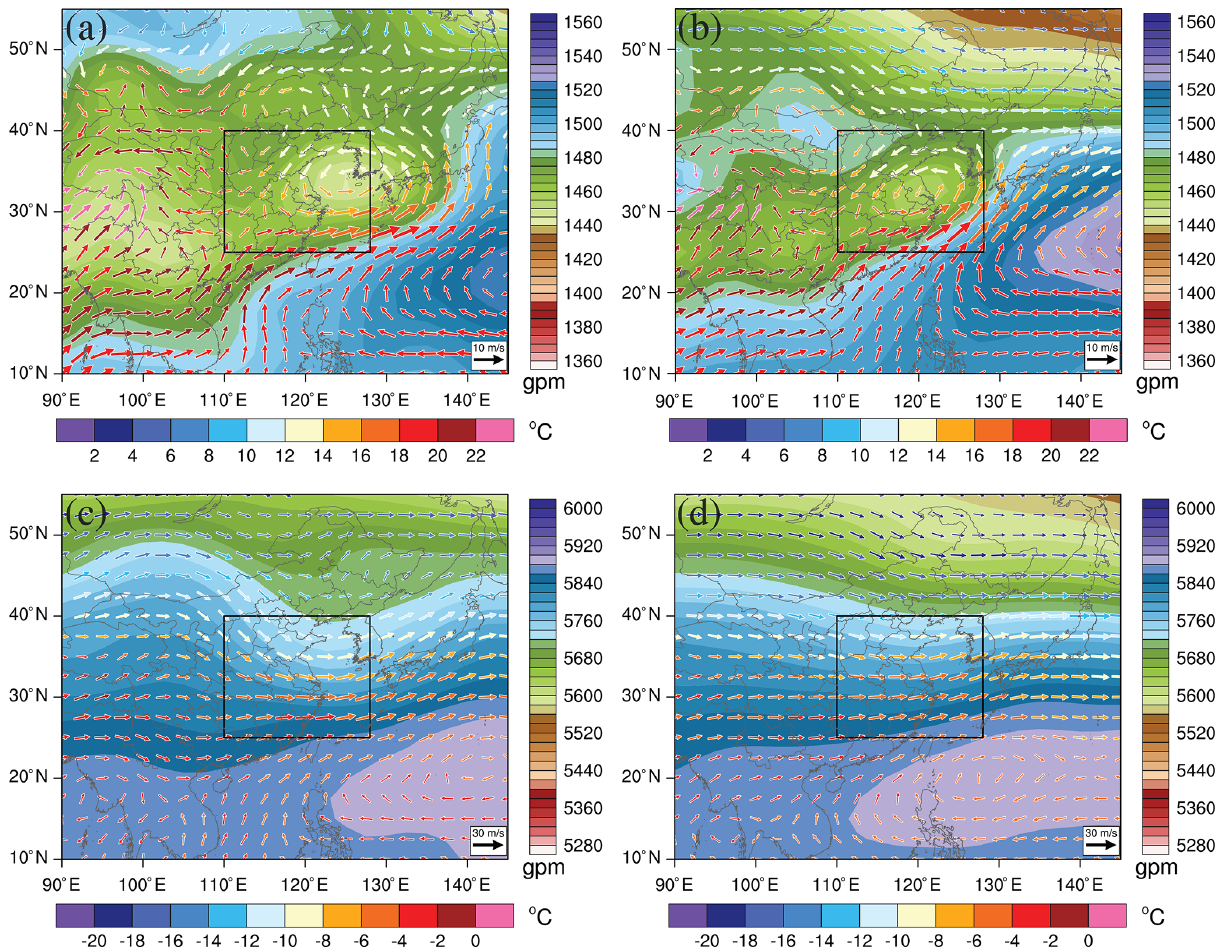
Figure 6. The geopotential height (shaded) and 850hPa wind with temperature (color vector) under (a) SWP3_Pos and (b) SWP3_Neg. The geopotential height (shaded) and 500hPa wind with temperature (color vector) under (c) SWP3_Pos and (d) SWP3_Neg. The boxed area in panels (a) – (d) encloses the